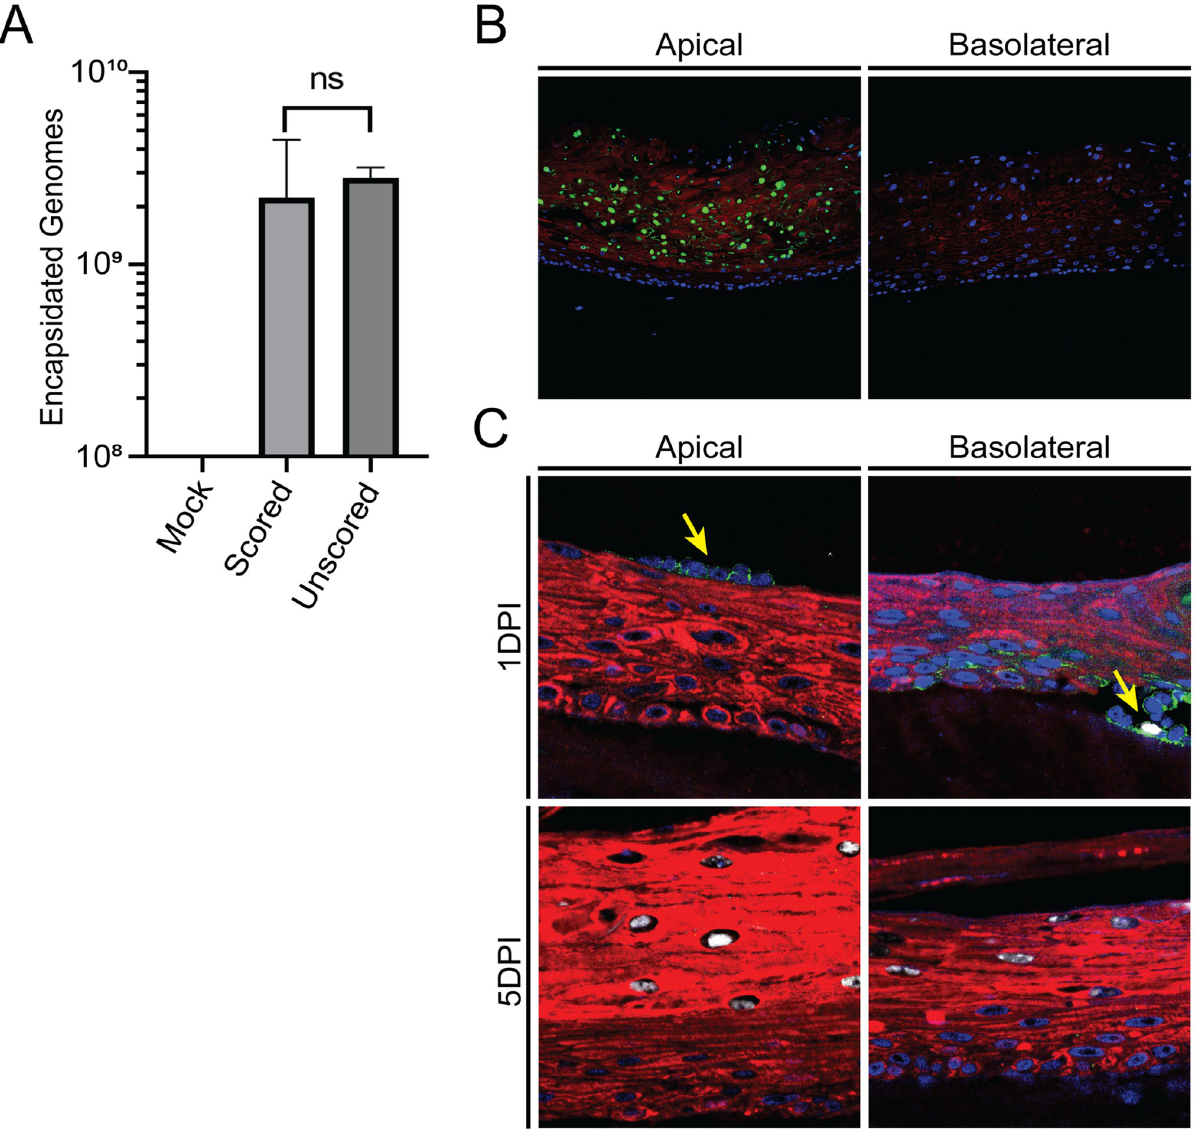
Fig 5. EBV can infect from either the apical or basolateral surface of organotypic cultures without scoring. (A) Scored or unscored organotypic cultures were infected with 2.5 x 10 6 virus-producing Akata cells. Quantification of encapsidated genomes produced by organotypic cultures was determined by PCR 6 DPI. A Welch two sample T-test determined that there was no significant difference (p = 0.418). (B) Virus-producing Akata cells were encased in collagen and applied to the apical surface of a 4 day organotypic culture or to the collagen plug prior to addition of keratinocytes. Hoechst (blue) was used to label the nuclei while cytokeratin 5 (red) was used to identify keratinocytes. Viral DNA was detected by in situ hybridization (green). (C) Virus-producing Akata cells were added to either the apical or basolateral surface of 4 day organotypic cultures. Akata B cells were detected using CD19 staining (green) at 1 DPI (yellow arrows) but were not seen at 5 DPI. Hoechst (blue) was used to label the nuclei while cytokeratin 5 staining (red) identified keratinocytes. Viral DNA was detected by in situ hybridization (white).